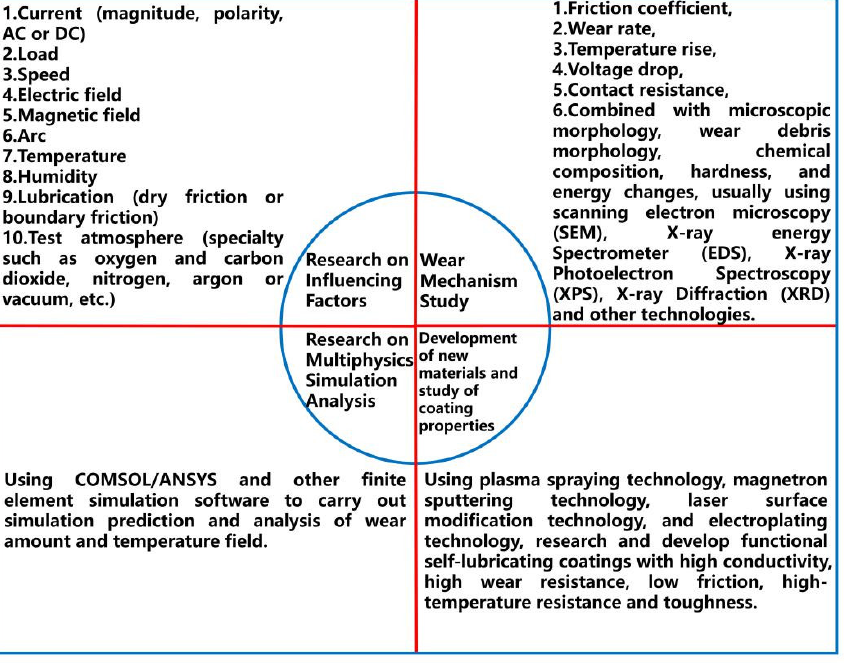
Figure 17. A summary of the research direction and content of the current-carrying friction and wear .